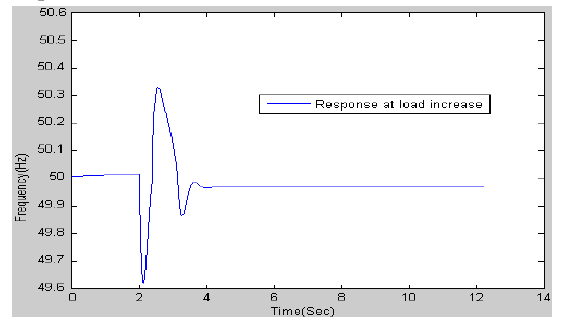
Fig. 8: Response of Proposed Hybrid Scheme for SHP at Unit Step